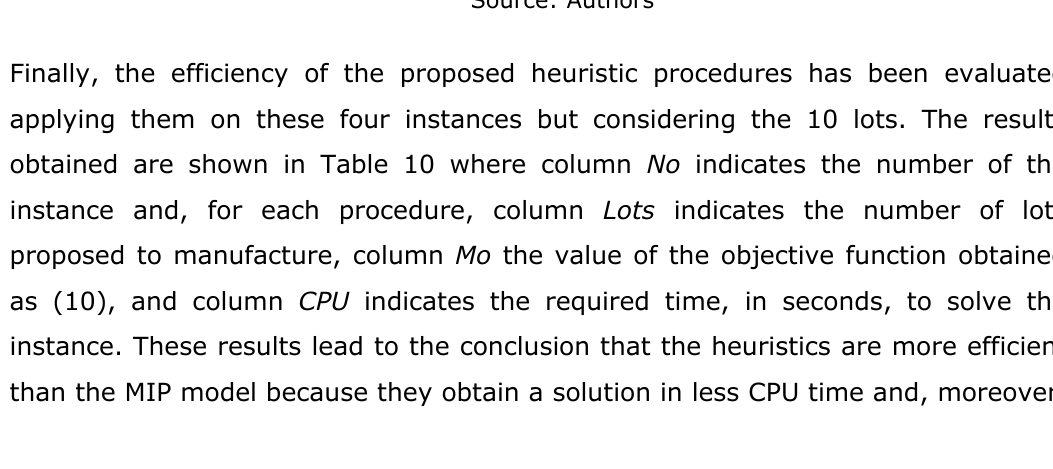
Tabla 9. “Comparison between results obtained by the proposed